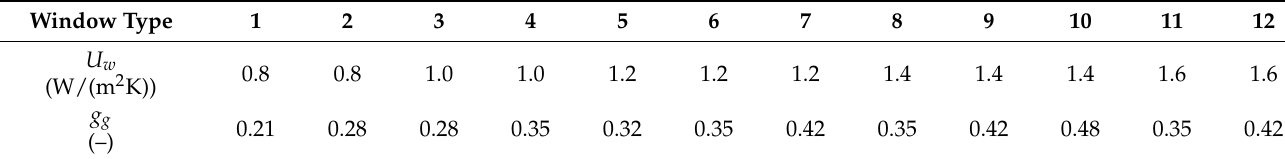
Table 10. Specific parameters of windows: U w —heat transfer coefficient of windows and g-factor transmittance glazing [43]. Window